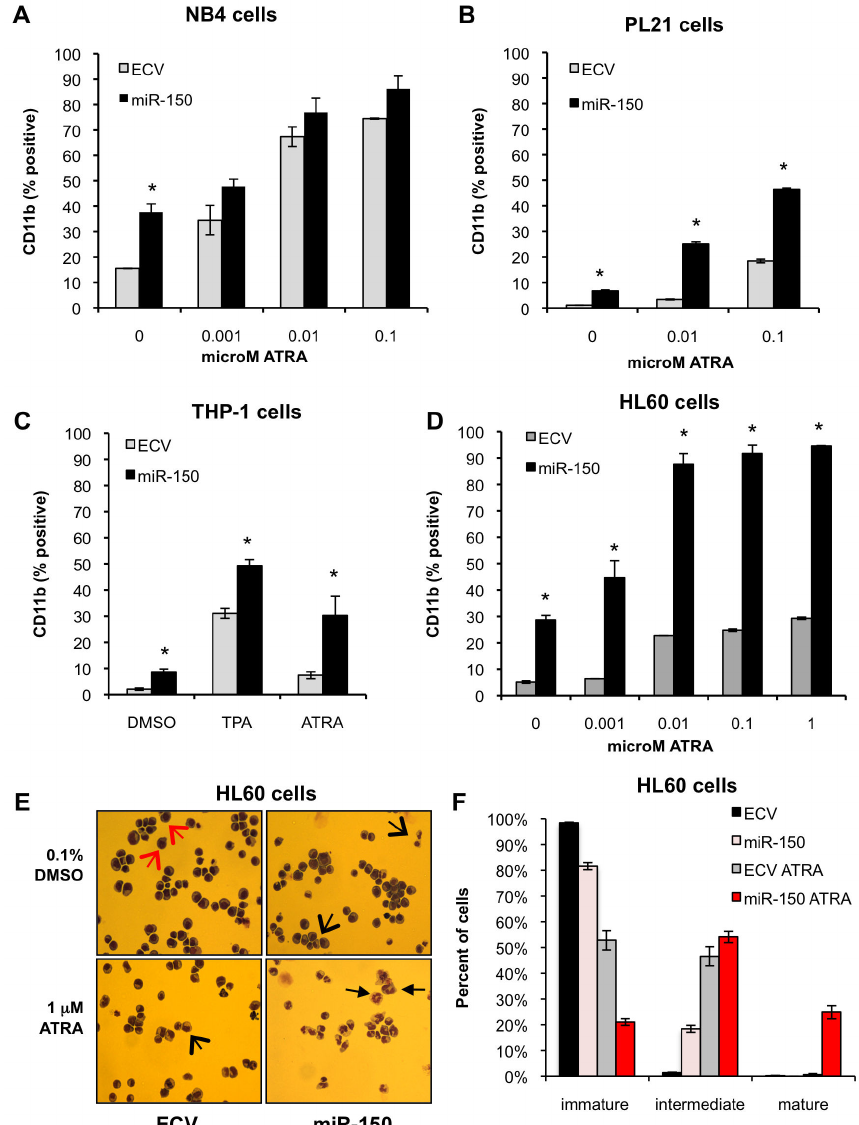
Figure 2. MiR-150 expression promotes myeloid differentiation in AML cell lines. AML cell lines NB4, PL21, HL60, and THP-1 were transduced with miR-150 or empty control lentiviral (ECV) supernatants, flow sorted for GFP, and assayed 7-21 days post transduction. (A) NB4 cells, an acute promyelocytic leukemia (APL) cell line with the t(15;17) PML-RARA translocation, were treated with the indicated concentrations of ATRA or vehicle control (0.1% DMSO) for 72 hours and assayed by flow cytometry for CD11b expression, displayed as percentage of CD11b positive cells. (B) PL21 cells, an APL cell line with FLT3 ITD, were assayed after 96 hours of ATRA treatment. (C) THP-1 cells, a MLL-AF9 rearranged monocytic AML cell line, were treated with vehicle control (0.1% DMSO) or TPA (12.5 ng/mL) for 24 hours, or DMSO or ATRA (1 µM) for 48 hours and then assayed. (D) HL60 cells, an AML cell line, were assayed after 96 hours of ATRA treatment. For all cell lines assayed, miR-150 expression induced CD11b expression in the absence or presence of TPA or ATRA. For all experiments the means of three independent experiments each performed in triplicate are shown; error bars represent standard deviations (* P≤0 . 05 , ** P≤0.005 for comparisons, Student’s t-test). (E) HL60 cells expressing miR-150 displayed increased morphological evidence of differentiation by Wright-Giemsa staining, most notable after exposure to 1 µM ATRA for 96 hours. These features included decreased nuclear to cytoplasmic ratio, lobulated nuclei, and granules. Immature cells are indicated by the large red arrows, intermediate differentiated cells are indicated by the large black arrows and mature myeloid cells by the small black arrows. (F) Quantitation of cells in different stages of myeloid differentiation was determined by Wright-Giemsa stain as described in Methods. Percentage of cells in each stage of differentiation displayed as an average of 10 fields (400 cells counted), error bars indicate standard deviations. doi: 10.1371/journal.pone.0075815.g002 PLOS ONE |